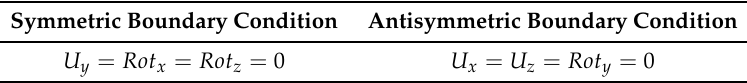
Table 1. Boundary conditions at the plane of symmetry of the